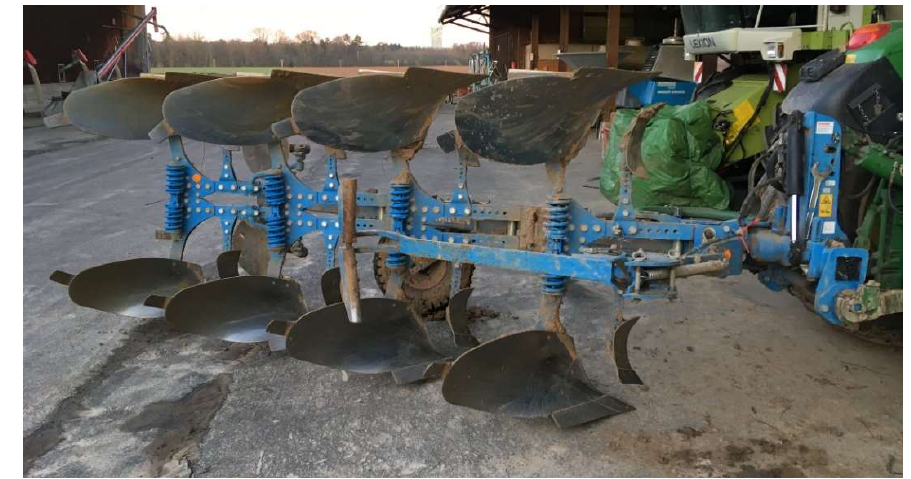
Figure 1. The mounted four-furrow moldboard plow that was used for the tillage operation.